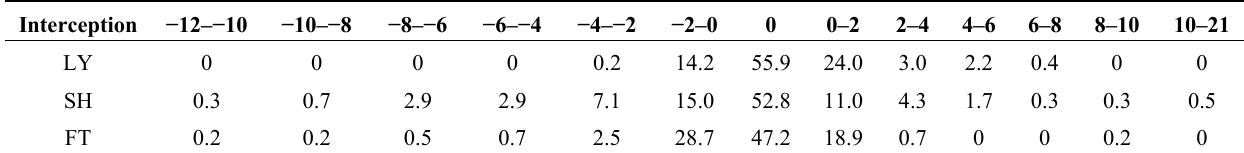
Table 15. Statistic distribution of interception variation in Scenario S1-S0 (area percentage, %).